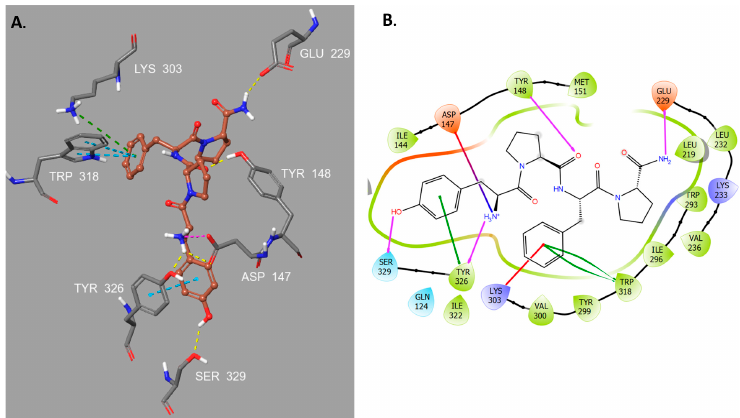
Figure 2. ( A ) Binding mode of morphiceptin 1 . Blue lines indicate π -cation interactions, and purple lines indicate salt bridges. The ligand is represented in brown and the receptor residues are represented in gray. ( B ) Two-dimensional diagram of the main interactions between morphiceptin and the residues involved in ligand recognition of the µ -opioid receptor (MOR) binding site. Purple lines represent hydrogen bonds, blue-red represent salt bridges, red lines represent π -cation, and green lines represent π -stacking. Hydrophobic residues are colored in green, negatively charged in red, polar in light blue and positively charged in purple. Molecules 2020 , 25 , x FOR PEER REVIEW